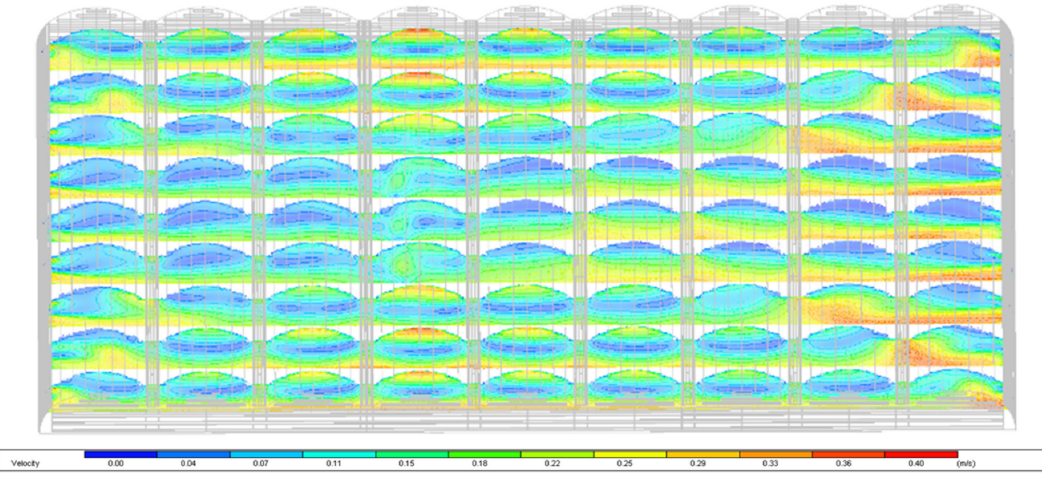
Figure 17. Wind speed cloud map of the crossed multi-arch greenhouse (outdoor wind speed 0 m/s).